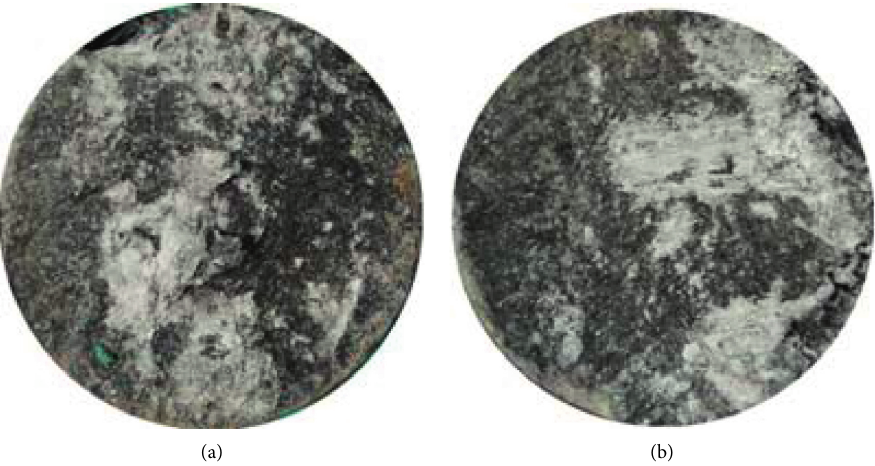
Figure 10: Under prepeak tiered cyclic shear loading. (a) Upper fracture surface. (b) Lower fracture surface.